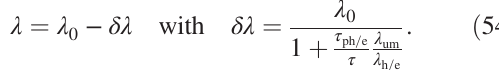
and graphene, evaluated e e